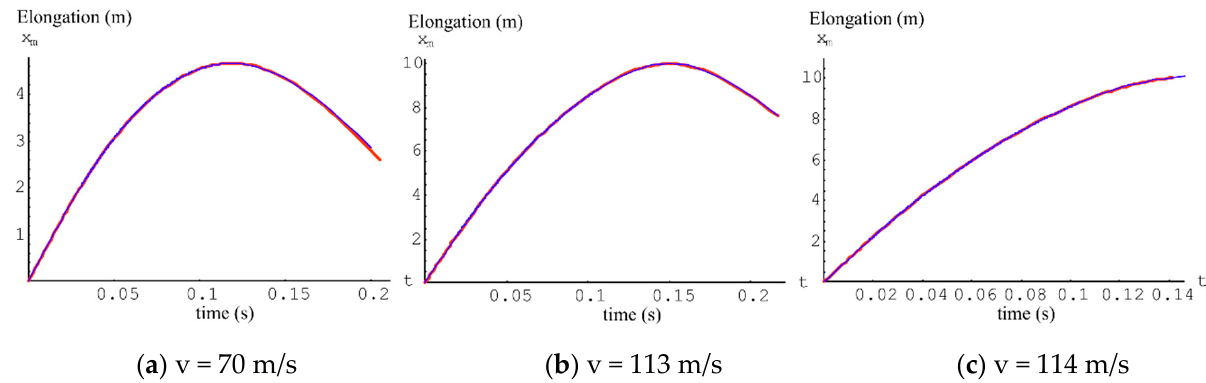
Figure 12. Elongations at various initial velocities (v = 70 m/s, 113 m/s, 114 m/s). Number of segments = 1000, red line: